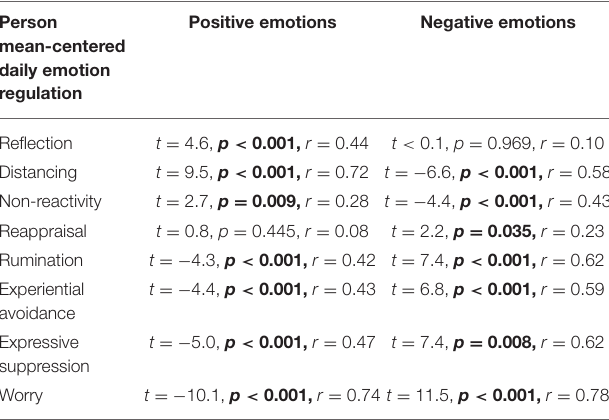
TABLE 3 | Associations between person mean-centered daily emotion regulation and daily positive and negative